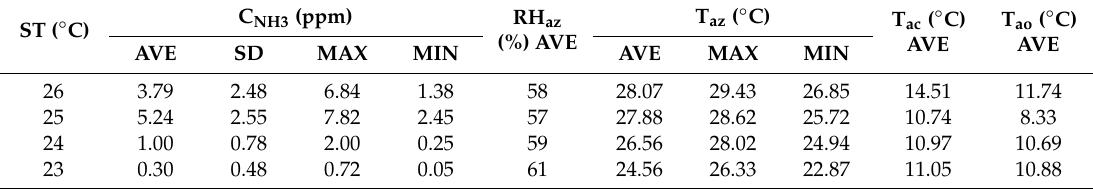
Table 2. Statistical values of environmental variables for di ff erent setpoint temperatures.